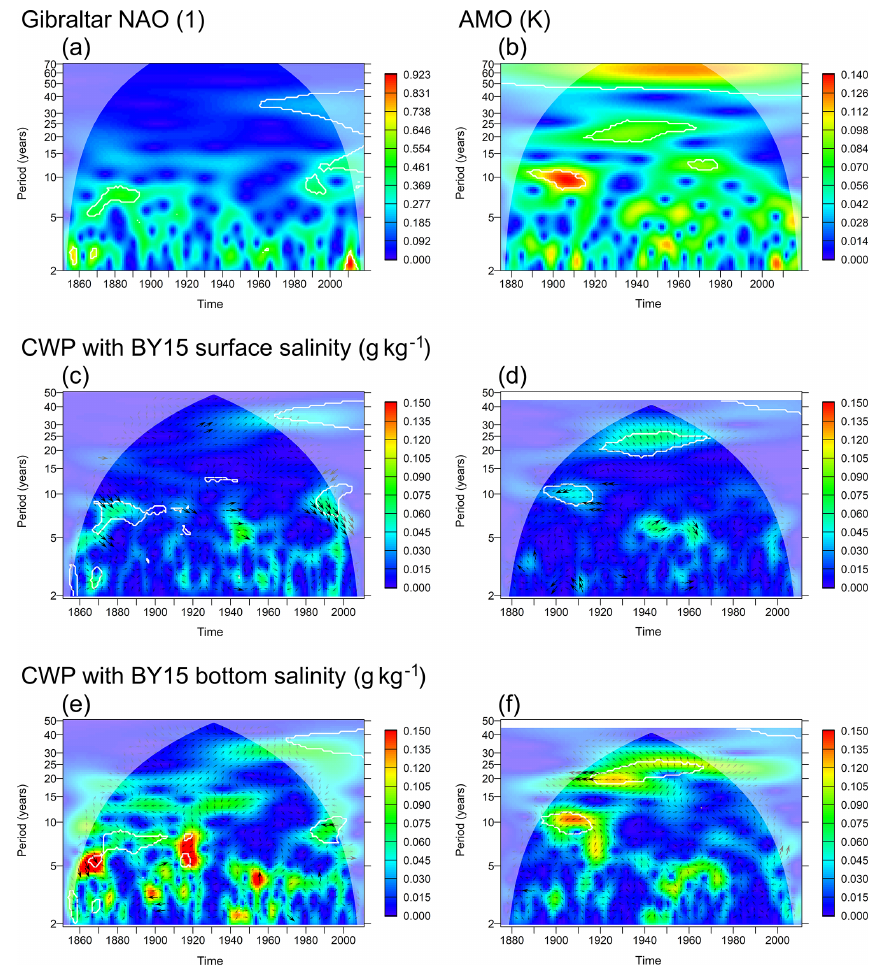
Figure 8. (a, b) Wavelet amplitudes (WAs) of NAO (Gibraltar–Iceland) and AMO index. (c–f) Common wavelet power (CWP) between modelled surface and bottom salinities at station BY15 and the normalized climate indices. White contours indicate that the WA or CWP is significant at the 95% confidence level with respect to a random shuffling of the annual values of the climate index. Arrows indicate relative phase: → : in phase; ↓ : climate index leading salinity by 90 ◦ . Thick arrows indicate phase stability (wavelet coherence >